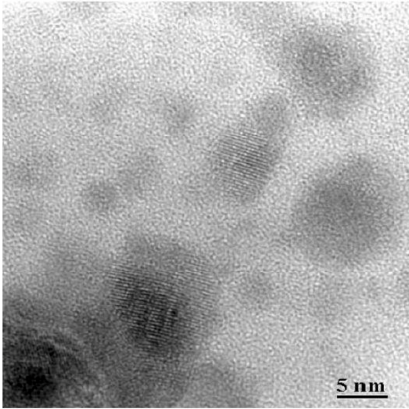
Figure 5. HRTEM image of Eu 3+ doped SiO 2 -GdF 3 GC film heat = treated at 400 °C [64].